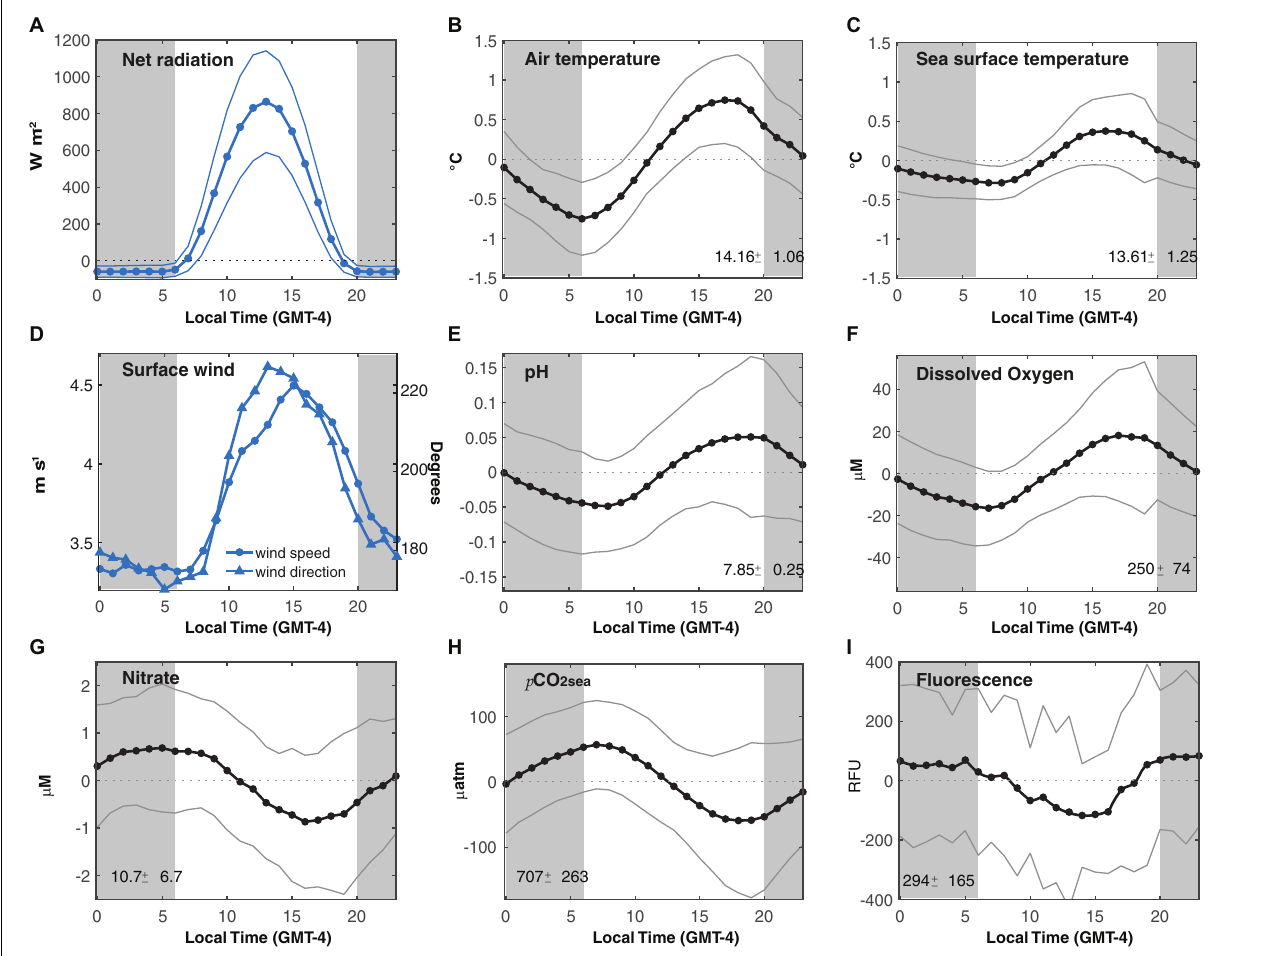
FIGURE 4 | Diel cycle of selected variables measured at buoy POSAR. (A) Net radiation, (B) Air temperature anomalies, (C) Sea surface temperature anomalies, (D) Surface wind speed and direction, (E) pH anomalies, (F) Dissolved oxygen anomalies, (G) Nitrate anomalies, (H) p CO 2 sea anomalies, and (I) Fluorescence anomalies. Dots represent the mean diel cycle and the thin line correspond to its standard deviation. Vertical gray bars indicate night-time. The mean and standard deviation of daily time series are shown in each